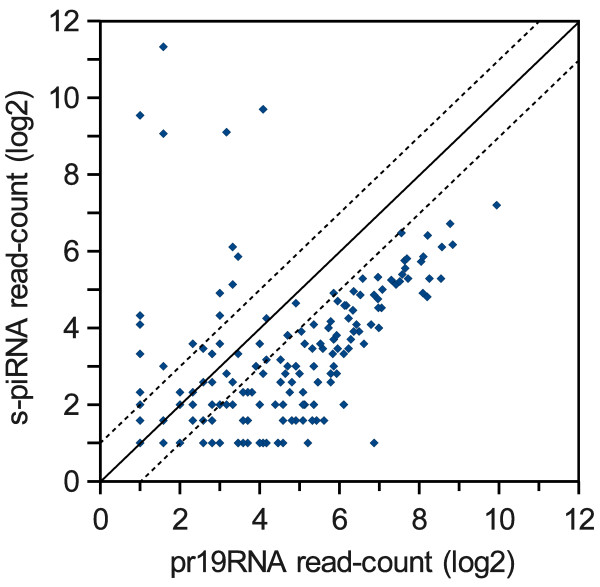
Abundance of pr19RNA relative to s-piRNAs The number of piRNA-related 19mers (pr19RNA) and secondary piRNAs (s-piRNAs) overlapping 2,5kb non-overlapping tiles across the genome were plotted. Only tiles overlapping both pr19RNA and s-piRNAs in the same sense were used and tiles with abundant p-piRNAs on the same strand were excluded.